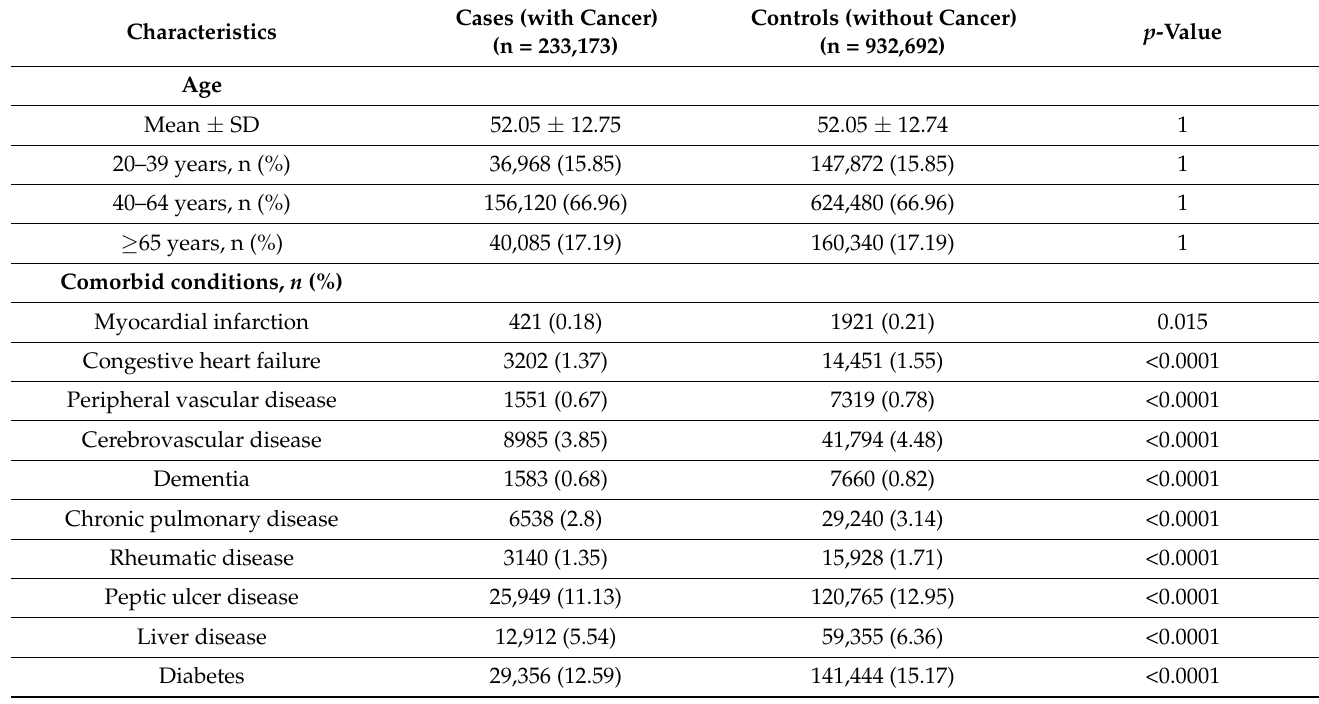
Table 1. Baseline characteristics of cases and controls for female